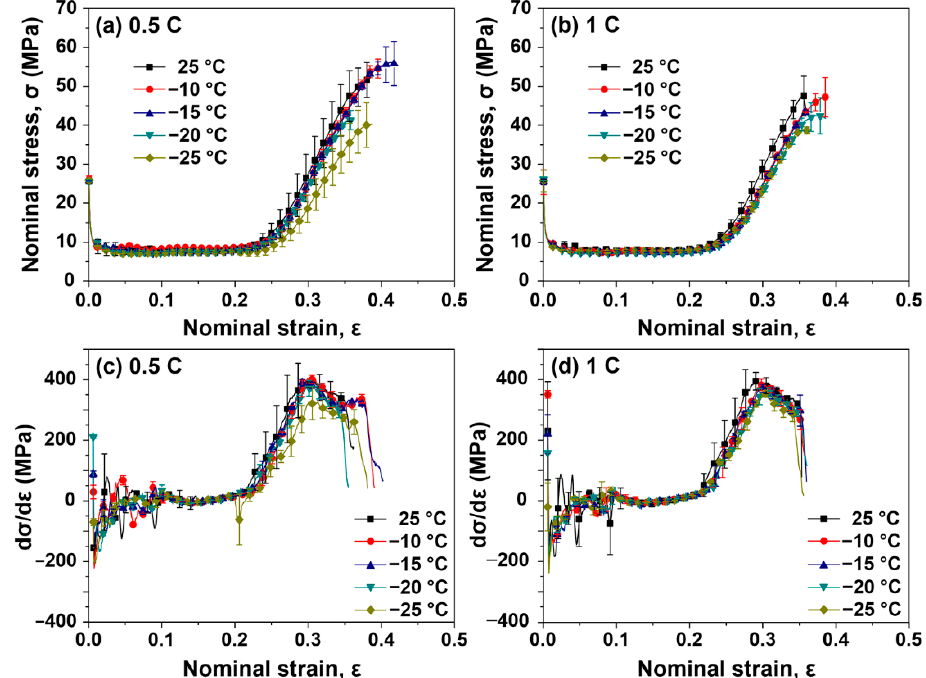
Figure 4. Nominal stress–strain and nominal modulus–strain curves of the 18650 lithium-ion battery cells charged at various environmental temperatures and rates.